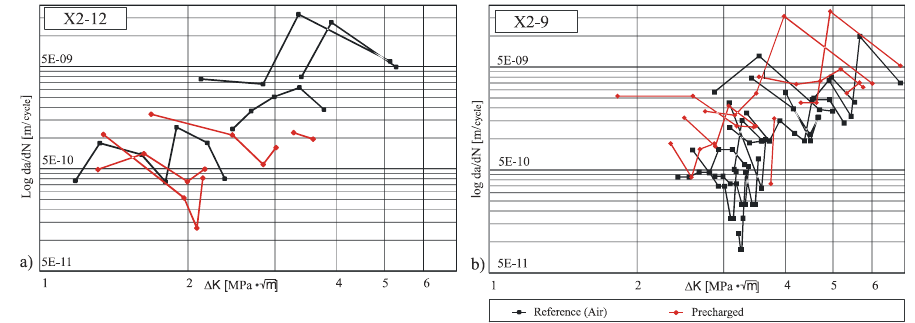
Figure 10. da/dN — ΔK curves of ( a ) X2 – 12 and ( b ) X2 – 9; measured on precharged samples (red) and Figure 10. da/dN— ∆ K curves of ( a ) X2–12 and ( b ) X2–9; measured on precharged samples (red) and reference (air) samples (black). reference (air) samples